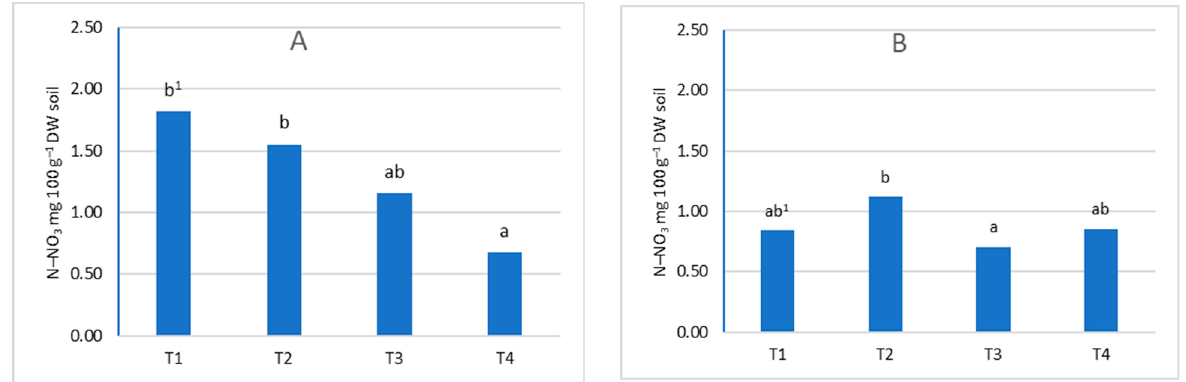
Figure 4. The content of N-NO 3 according to the date of sampling ( A )—in the soil layer 0–20 cm, ( B )—in the soil layer 21–40 cm. 1 means that the same letters are not significantly different at α = 0.05 (Duncan’s test). Table 3. Influence of climatic conditions on ammonia nitrogen content in soil.